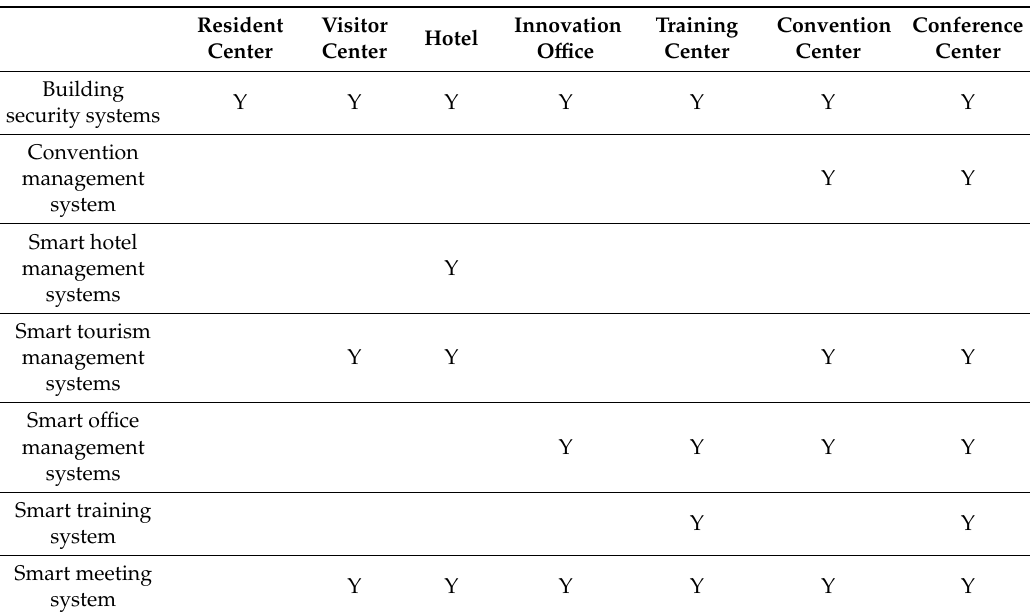
Table 2. Buildings spaces and the